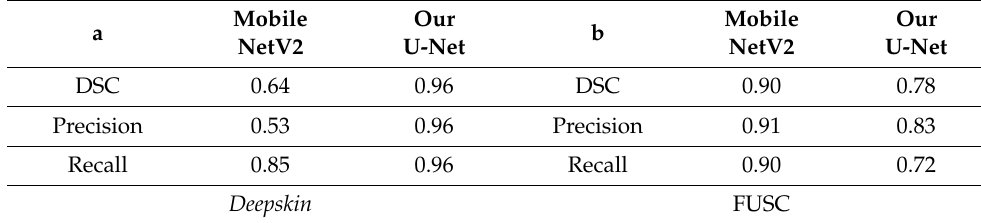
Table 2. Comparison of the results obtained by the MobileNetV2 model (Wang et al.) and the U-Net model proposed in this work, on the two available datasets, (a) Deepskin and (b) FUSC, respectively. We re-trained the MobileNetV2 on the FUSC dataset for the reproducibility of Wang et al. results. The U-Net model was trained only on the Deepskin dataset as described in Section